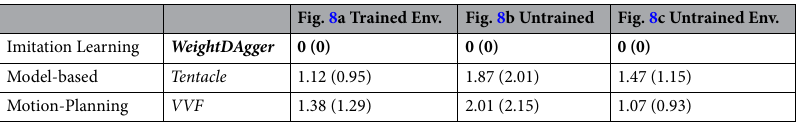
Table 2. Collision Rate. * Note . The average collision rate per 100m over 5 trials. The parentheses indicate additional results where the vehicle drove from the finish to start points. Significant values are in bold.